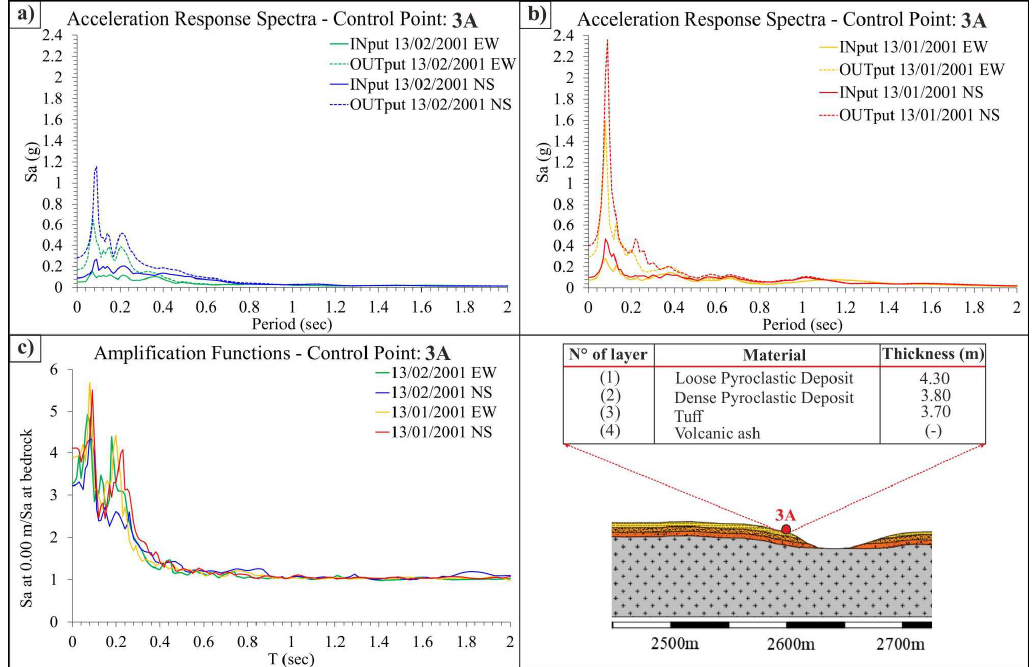
Figure 15. Section AA′: numerical control point 3A spectral responses obtained by 2D numerical analyses using LSR2D software. ( a ) Comparison among the SA of the two components of the 13 February 2001 earthquake. ( b ) Comparison among SA of the two components of the 13 January 2001 earthquake. ( c ) Amplification functions related to the four input motions.